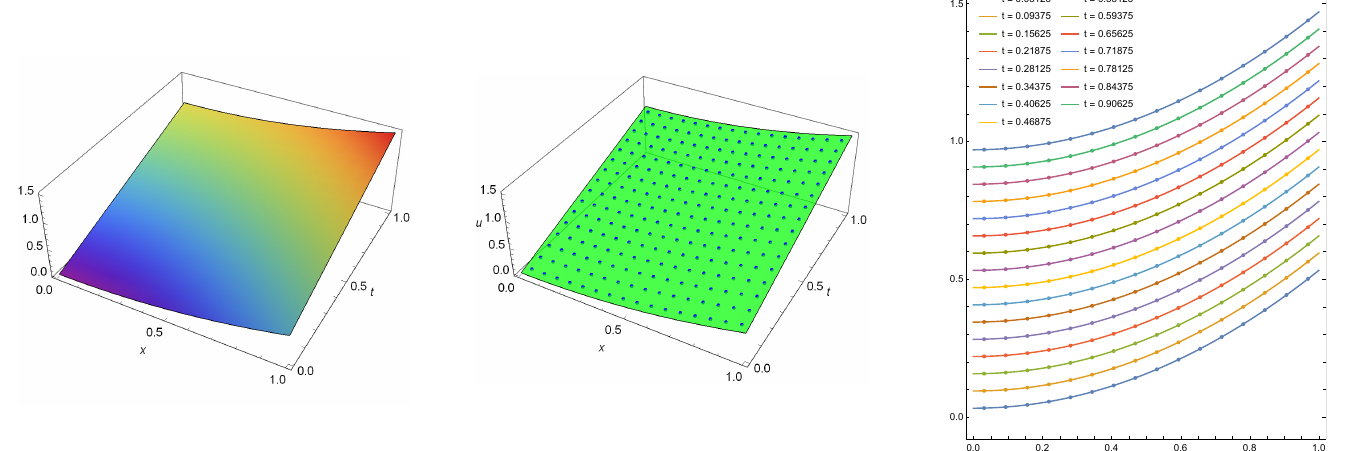
Figure 3. The numerical solution (points) with exact solution computed for Example 2 when M = 16, µ = 1, α = 19 / 10.